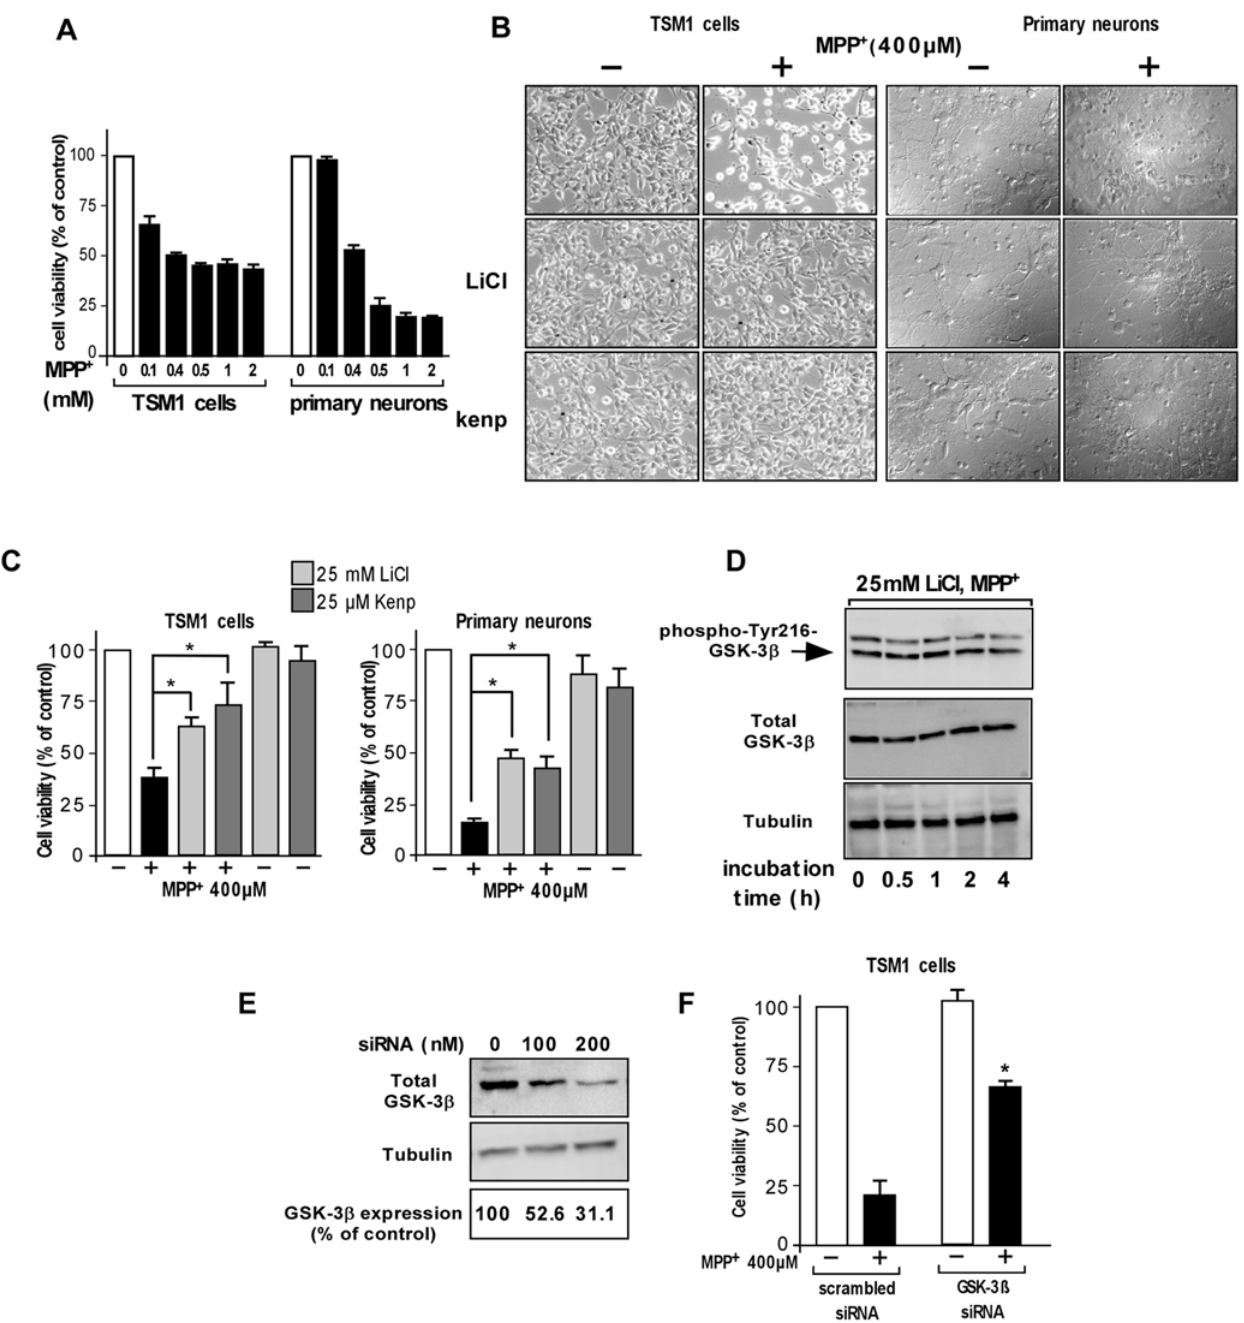
Figure 2. Effect of the down-regulation of GSK-3 b activity on MPP + -induced neuronal cell death. (A) TSM1 and primary cultured neurons were treated with MPP + (from 0.1 to 2 mM) for 15 h and cell viability was monitored by MTS assay. The data are expressed as the percentage of viable neurons when compared to untreated neurons and are the mean of three independent experiments with triplicate determinations 6 S.D. (B) Phase- contrast pictures of representative microscopic fields of TSM1 ( left ) and primary cultured neurons ( right ) pre-treated with 25 mM LiCl or 25 m M kenpaullone for 15 min, and then treated with saline or MPP + for additional 15 h at 37 u C. Magnification, 6 10. (C) TSM1 neurons ( left ) and mouse primary neurons ( right ) were pre-treated with LiCl or kenpaullone (25 mM and 25 m M, respectively), then incubated with MPP + (400 m M) for 15 h at 37 u C and cell viability was assessed using the MTS assay. The data are expressed as the percentage of viable neurons when compared to untreated neurons and are the mean of nine independent experiments with triplicate samples 6 S.D. One-way ANOVA * p , 0.01 versus saline-treated cells. (D) TSM1 neurons were pre-treated with LiCl (25 mM) for 15 min and co-incubated with 400 m M MPP + for the indicated times (0.5, 1, 2 and 4 h) and total proteins were extracted and anaylzed for phospho-Tyr216-GSK-3 b , total GSK-3 b and b -tubulin contents by Western blotting. (E, F) TSM1 cells were transfected with scrambled siRNA (200 nM) or GSK-3 b specific siRNA (100 or 200 nM) as described in Materials and Methods. Two days post- transfection, cells lysates were analyzed for total GSK-3 b immunoreactivity ( upper panel ) by Western blotting (F). To determine the correction factor of load, blots were reprobed with the anti- b -tubulin antibody ( middle panel ). The expression level of GSK-3 b was estimated by densitometry analyses performed with a ‘‘ National Institutes of Health ’’ I MAGE software and expressed as the percent of control conditions. (E) Alternatively, scrambled- or GSK-3 b specific- siRNA-transfected cells were treated with 400 m M MPP + for 15 h at 37 u C and the cell viability was monitored using MTS assay.